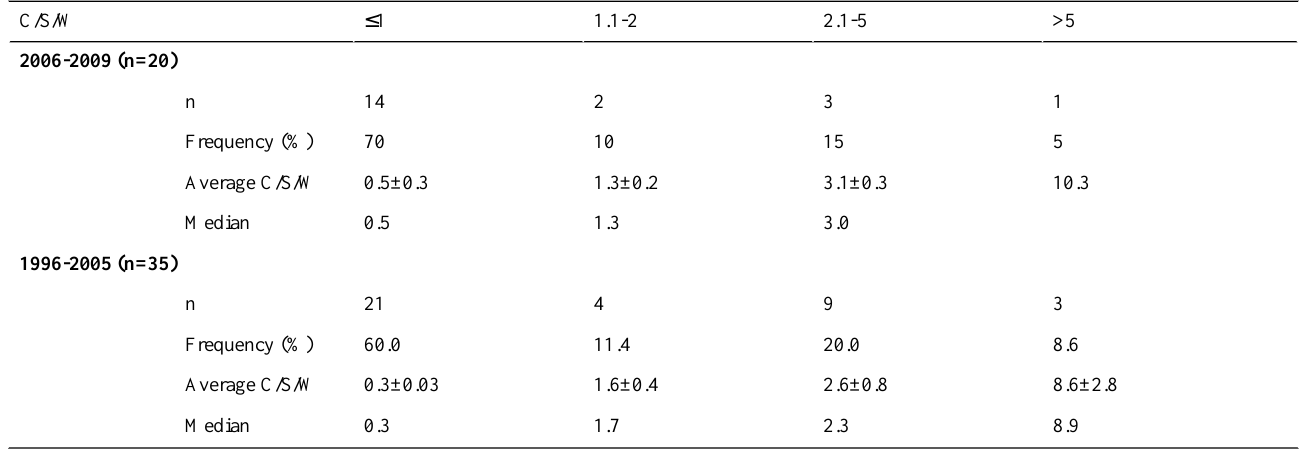
Table 4. The number of programs (n), percentage frequency, average (±SD), and median number of C/S/W for services reporting pre- and post-2006